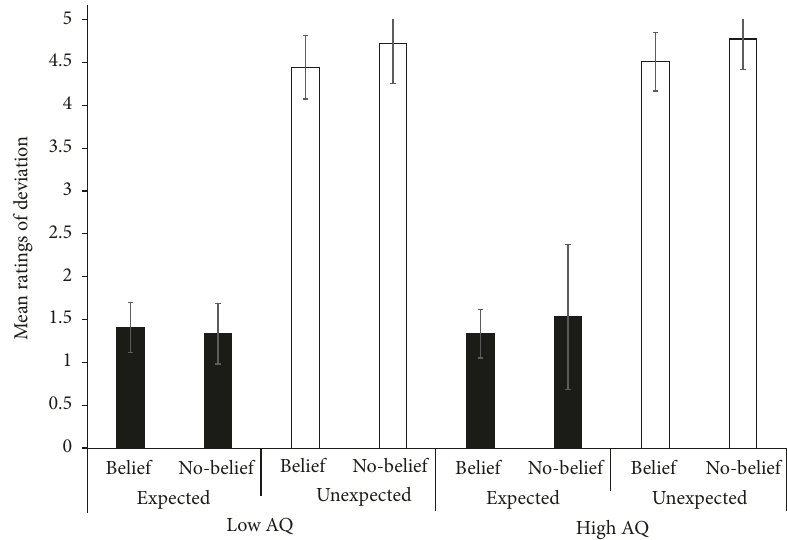
Figure 2: Mean ratings of deviation in all